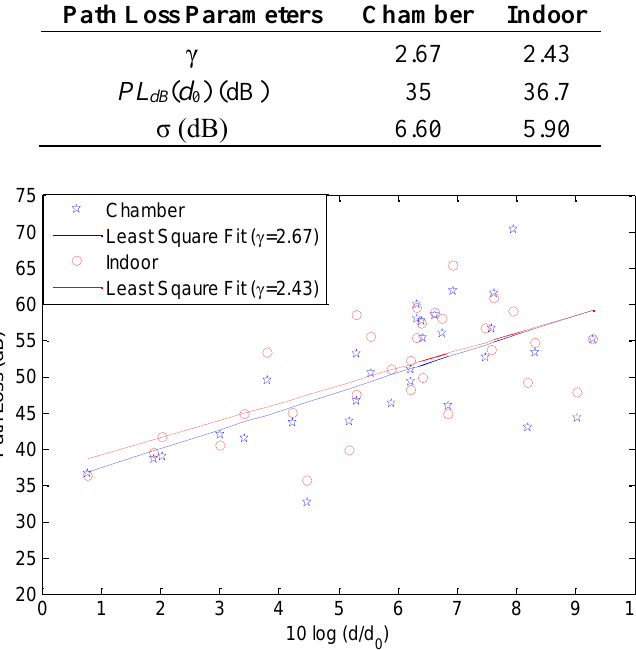
Figure 9. Measured and modeled path loss for on-body channel vs. logarithmic transmitter (Tx) and receiver (Rx) separation distance for the dual band PIFA at 2.45 GHz.